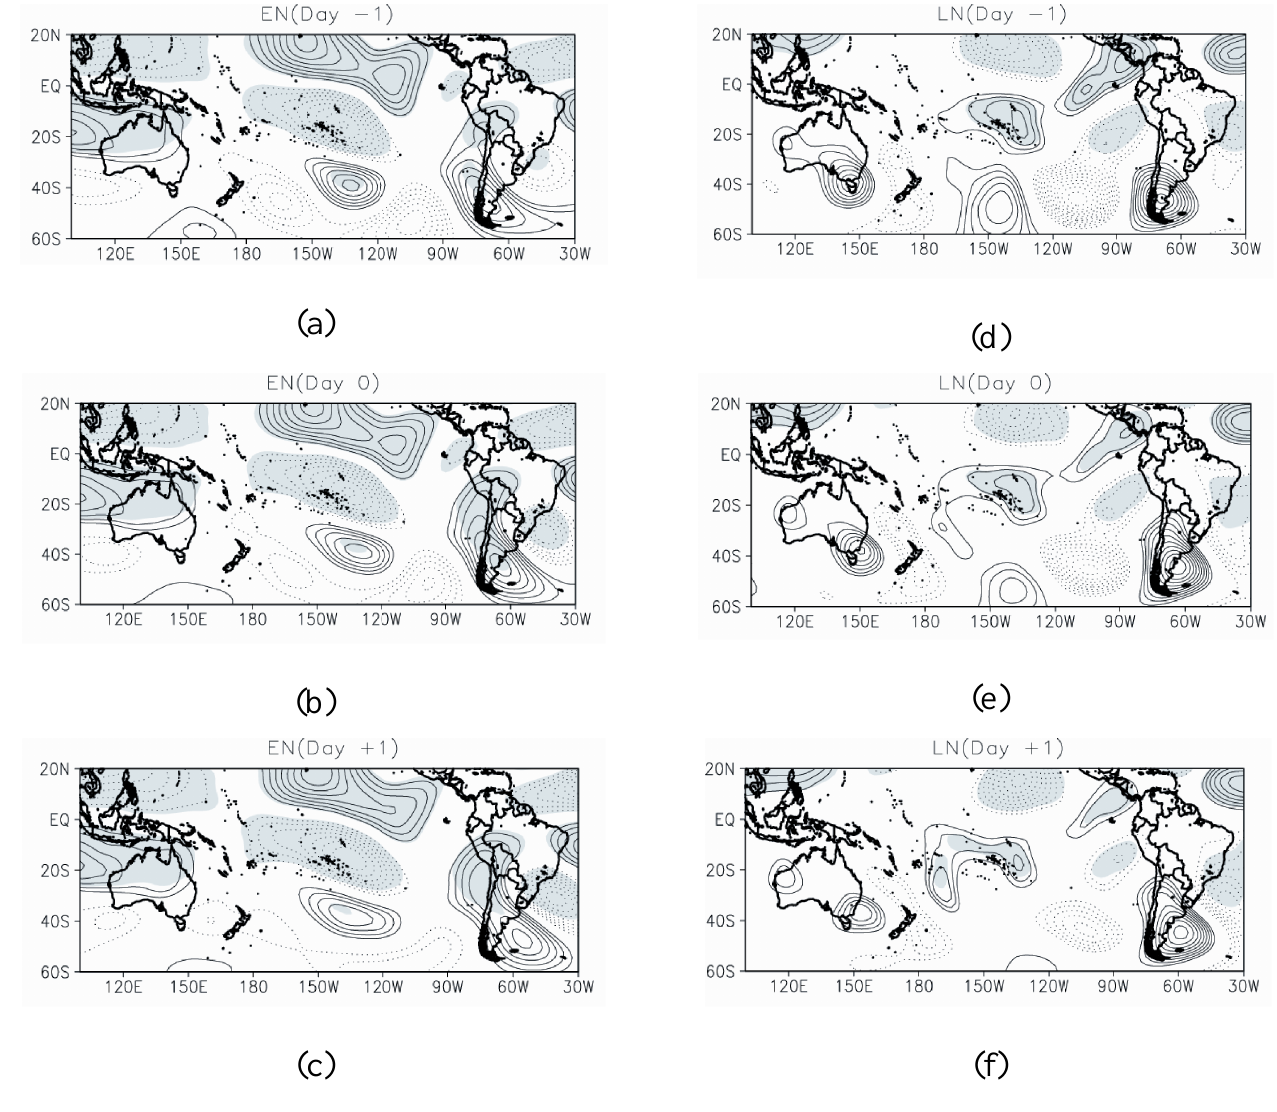
Fig. 4. 200hPa zonally asymmetric streamfunction anomaly for SALLJ composites. Left panels: EN years of (a) day − 1; (b) day 0 and (c) day +1 of the maximum SALLJ intensity. Right panels similar to the left but for: LN years of (d) day − 1; (e) day 0 and (f) day +1. Contour interval is 1 × 10 6 m 2 s − 1 . Negative contours are dotted and the zero contours are omitted. Areas where anomalies are statistically significant at the 95% level are shaded in